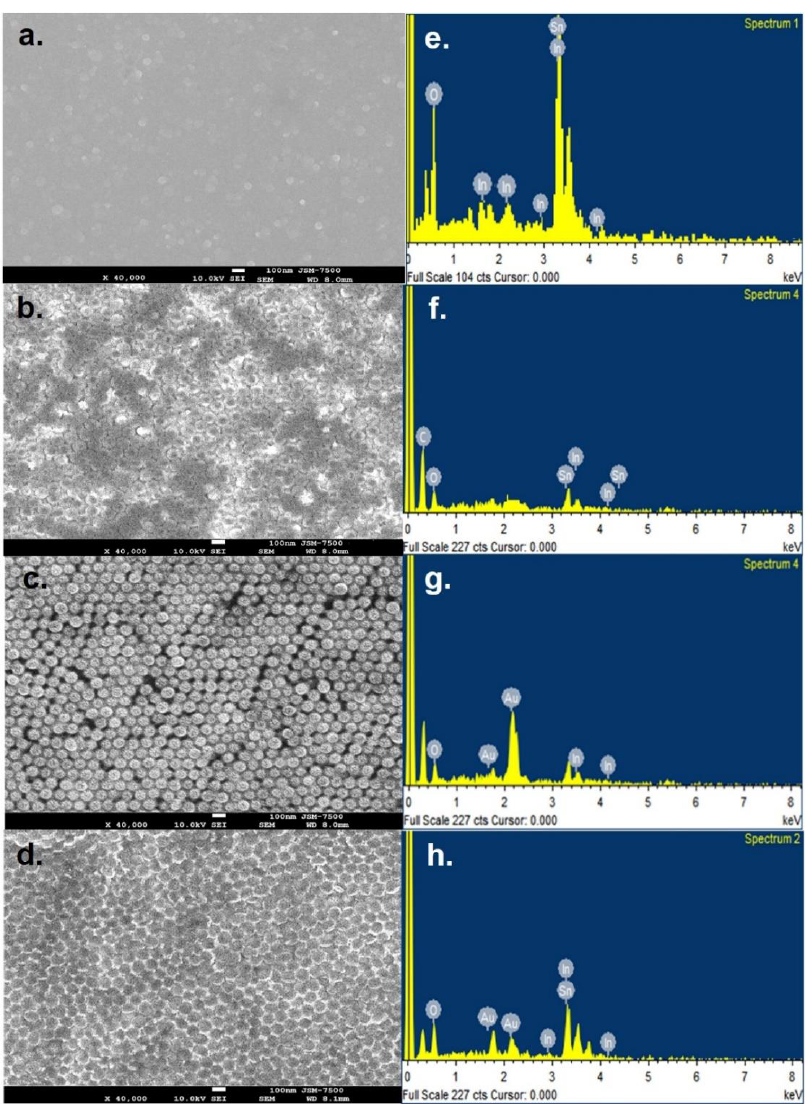
Figure 2. Field emission-scanning electron microscopy (FE-SEM) micrographs of ( a ) bare ITO, ( b ) polystyrene (PS) nanobead-covered ITO, ( c ) billowy gold nanostructure (BGN), ( d ) gold nanoframe array (GNA), and energy-dispersive X-ray spectroscopy (EDX) spectra of ( e ) bare ITO, ( f ) PS nanobead-covered ITO, ( g ) BGN, and ( h ) GNA.